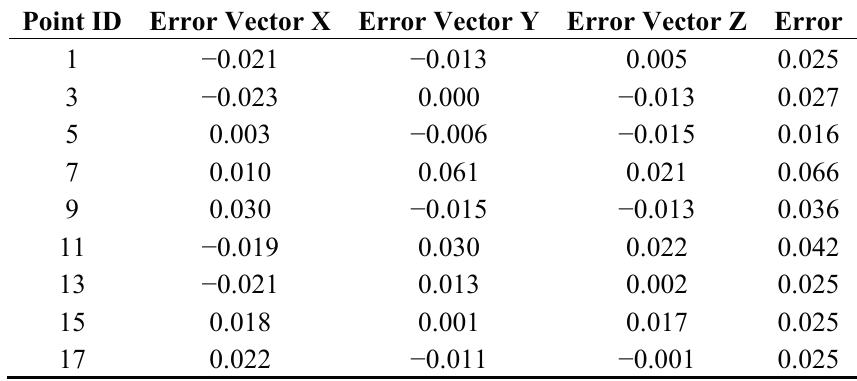
Figure 17. Check point distribution of ( a ) the seminar room; and ( b ) the corridor. Table 1. Accuracy assessment results for point-cloud data of the seminar room (unit: